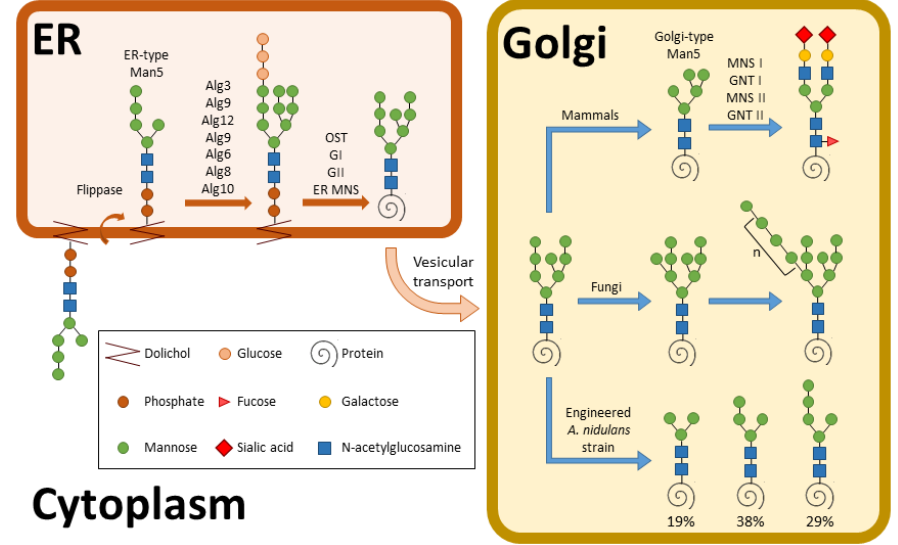
Figure 2. Native and engineered N-glycosylation pathway in Aspergillus .